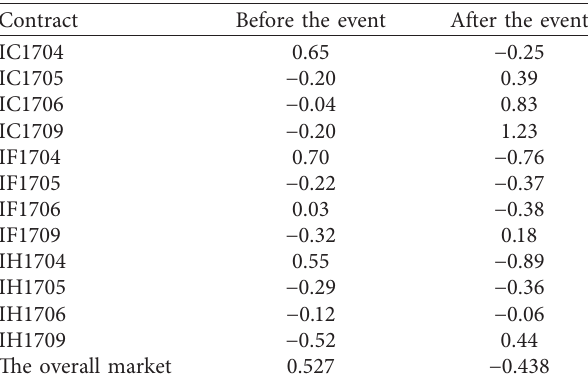
Table 16: The pricing efficiency of IC, IF, and IH contracts. Contract Before the event After the